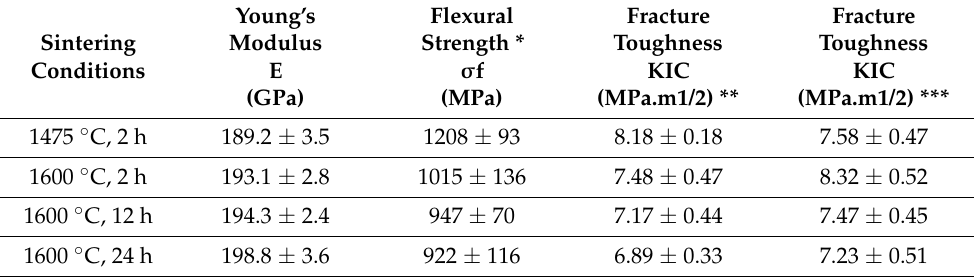
Table 2. Mechanical properties of Y-TZP-based ceramics after